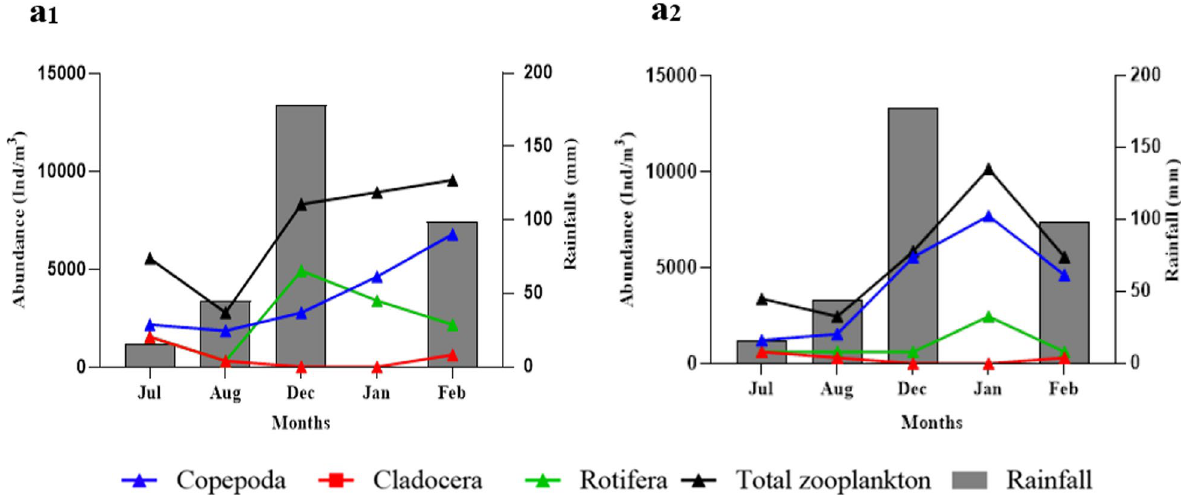
Fig. 10 Zooplankton abundance fluctuation with rainfall during July 2018–February 2019. a1 Vavuniya reservoir. a2 Thandikulam